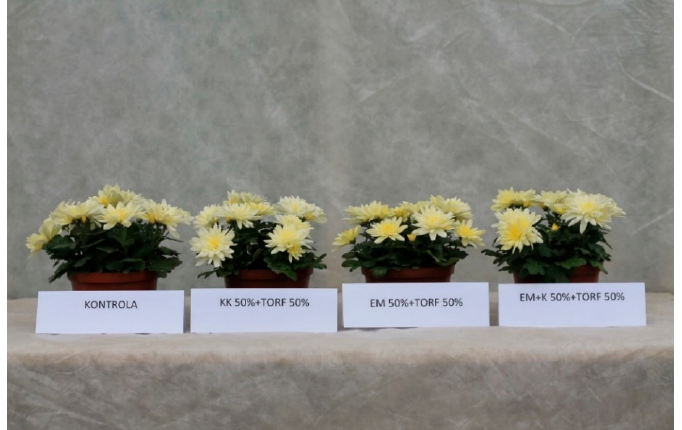
Figure 4. The quality of chrysanthemum (KONTROLA-control, KK 50% + TORF 50%-compost KK 50% + peat 50%, EM 50% + 50%TORF-compost EM 50% + peat 50%, EM + K 50% + 50%TORF-compost EM + 50% + peat 50%).